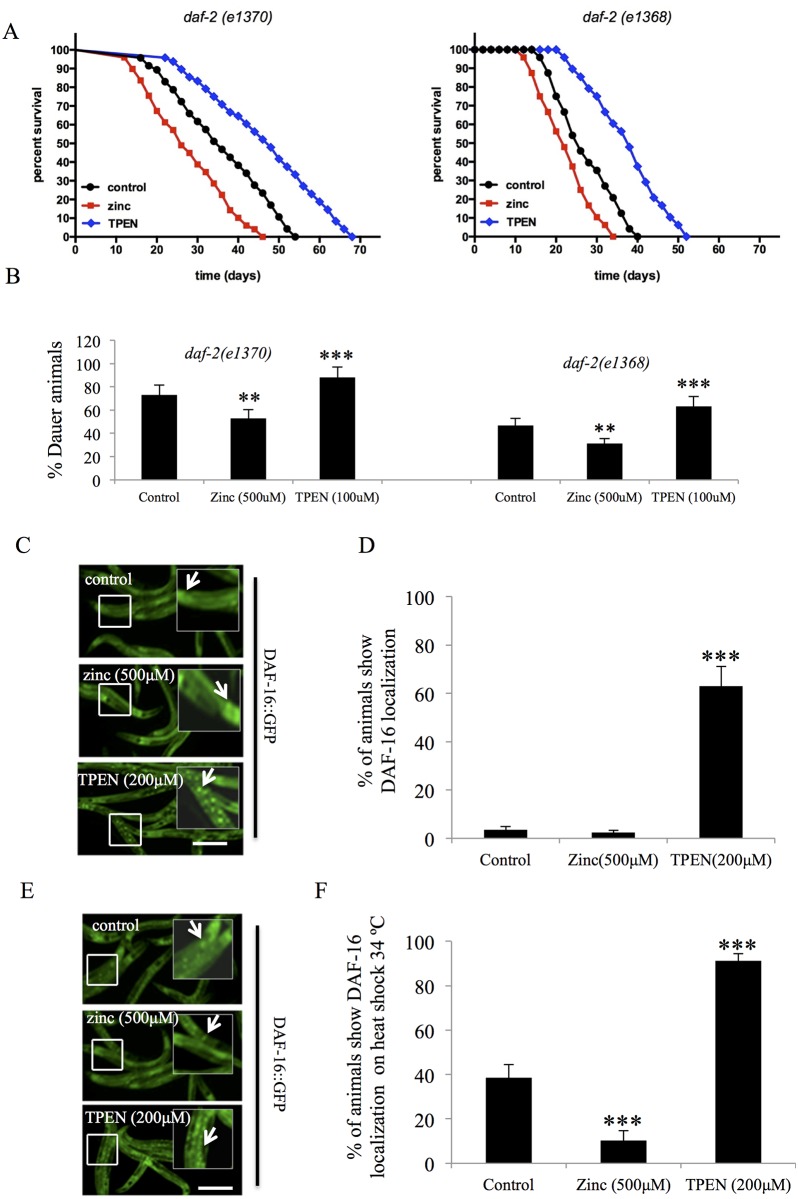
Zinc availability alters dauer formation, DAF-16 localization, and lifespan of insulin signaling pathway mutants in C. elegans.(A) Kaplan-Meier survival curve of worm populations exposed to zinc or TPEN. Worms with null alleles for daf-2 were exposed to 500μM ZnSO4 or 200μM TPEN at L4 stage animals. Mean and maximum population lifespan were reduced with zinc and increased with TPEN treatment (p < 0.0001, log rank test). (B) Changes in dauer formation in worm populations exposed to zinc or TPEN as larvae. Worms with null alleles for daf-2 were exposed to 500μM ZnSO4 or 200μM TPEN at L3 stage and collected at one-day old adult animals and analyzed for dauer formation. Worms supplemented with zinc had a reduced number of worms in the dauer state, whereas worms treated with TPEN had an elevated number of worms in the dauer state (**, p<0.001, ***, p<0.0001, t-test). Data indicates the mean ± SD of 3 independent experimental replicates. (C) Imaging DAF-16 localization in worm populations exposed to zinc or TPEN at 22°C. DAF-16::GFP transgenic worms were exposed to 500μM ZnSO4 or 200μM TPEN at L3 stage and measured for DAF-16 localization of one-day old adult animals. Representative micrographs showed that the subcellular localization of DAF-16::GFP was more evident in the nucleus when worms were exposed to TPEN, compared to control and zinc-supplemented worms. Scale bar = 200μm. (D) Quantifying DAF-16 localization in worm populations exposed to zinc or TPEN at 22°C. GFP fluorescence from DAF-16::GFP transgenice worms was imaged by fluorescence microscopy and scored for elevated nuclear DAF-16 localization. Data is represented as mean ± S.D using results of 3 experimental replicates (***, p<0.0001, log rank test). (E) Imaging DAF-16 localization in worm populations exposed to zinc or TPEN at 34°C. DAF-16::GFP transgenic worms were exposed to 500μM ZnSO4 or 200μM TPEN at L3 stage and measured for DAF-16 localization of one-day old adult animals, after exposure to heat shock at 34°C for 5 min. Representative micrographs showed that the subcellular localization of DAF-16::GFP was reduced in the zinc treated group and elevated in in the TPEN group, compared to control worms. Scale bar = 200μm. (F) Quantifying DAF-16 localization in worm populations exposed to zinc or TPEN at 34°C. GFP fluorescence from DAF-16::GFP transgenic worms was imaged by fluorescence microscopy and scored for elevated nuclear DAF-16 localization. Data is represented as mean ± SD using results of 3 experimental replicates (***, p<0.0001, log rank test)